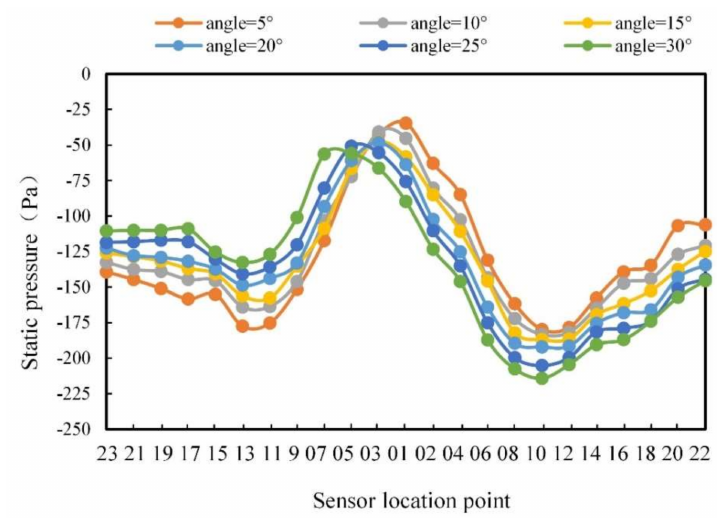
Figure 18. Pressure distribution at di ff erent flow angles.